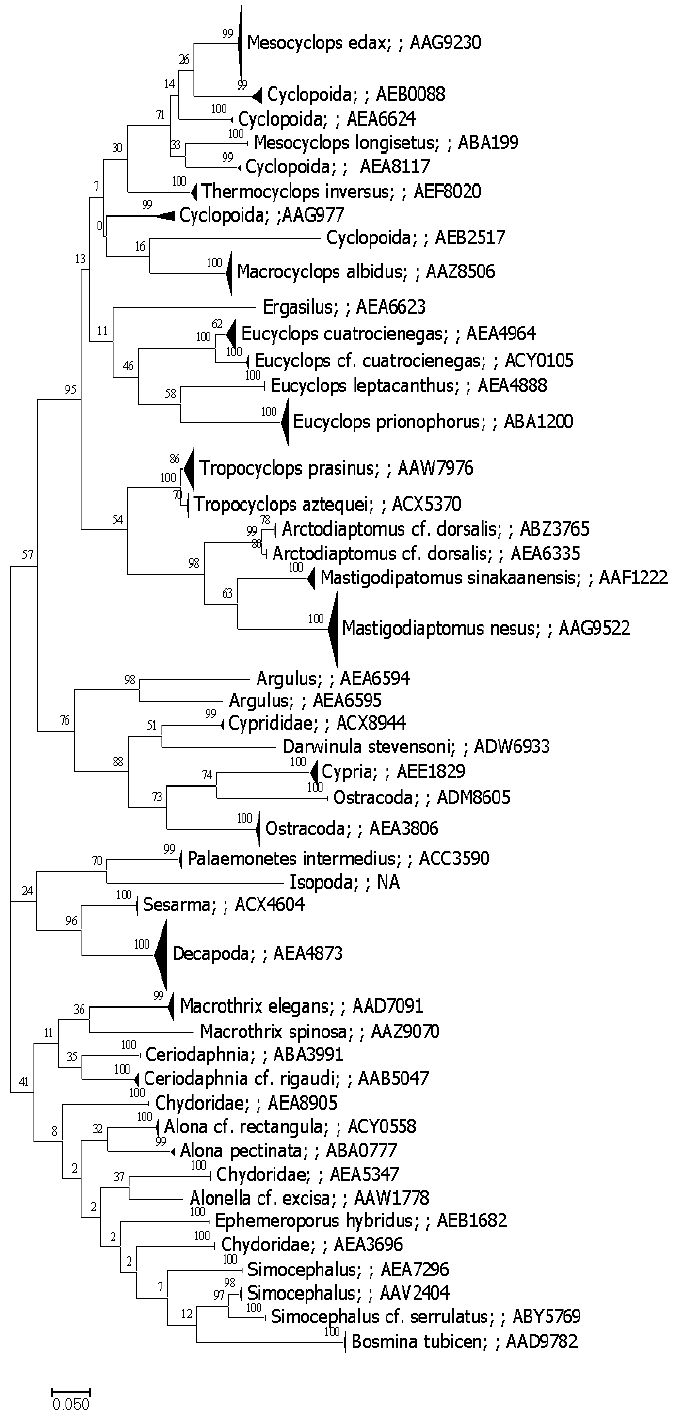
Figure 4. Simplified tree for Crustacea present in the samples. Numbers represent the aquatic system as presented in Table 1. The last number corresponds to the BIN assigned in BOLD. Bootstrap support values are shown in each branch.